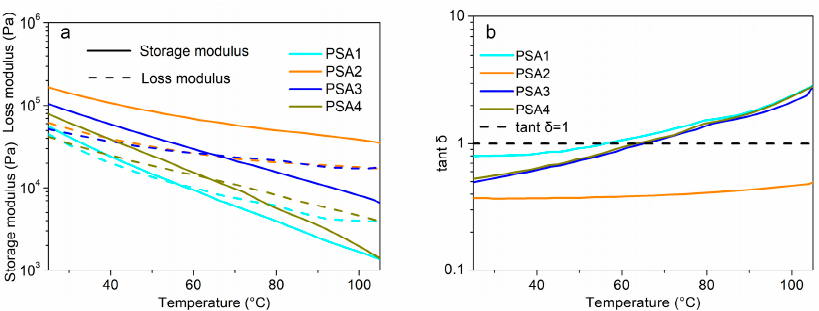
Figure 8. ( a ) Temperature sweeps of the four WPU-PSAs from 25 to 105 °C. ( b ) Loss factor of four WPU-PSAs over a temperature range from 25 to 105 °C.